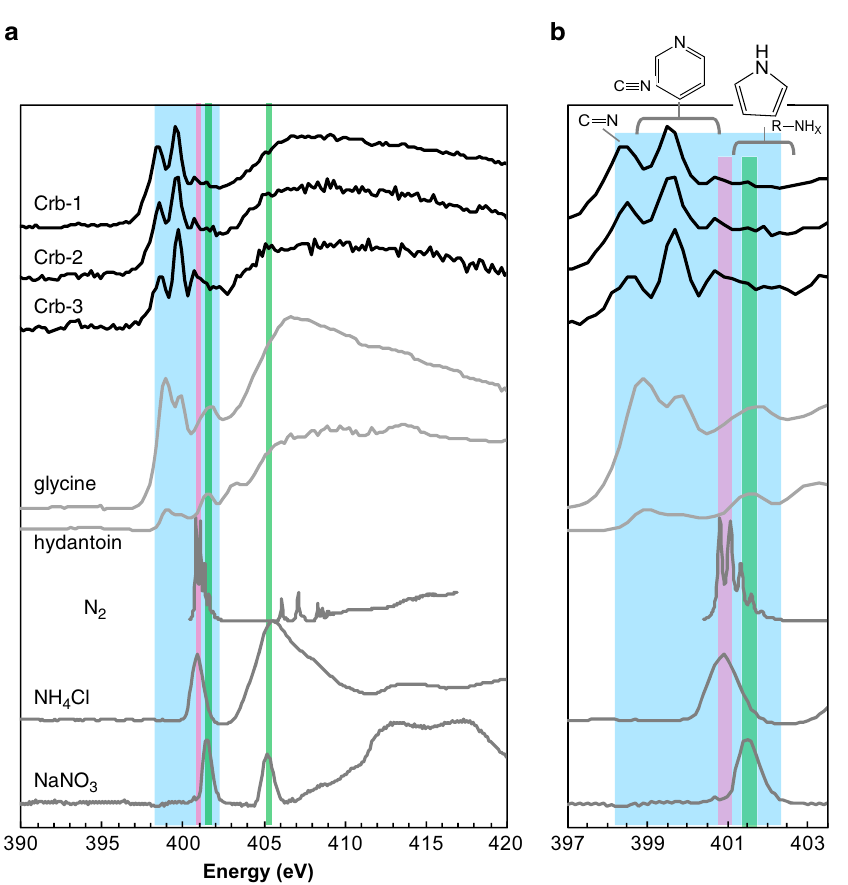
Fig. 2 Nitrogen K-edge XANES spectra. a A whole spectral image. The upper three (Crb-1 to Crb-3) are ALH carbonates, the others are the selected reference compounds. b An enlarged area of the energy between 397 and 403.5 eV. Signi fi cant absorption peaks for N 2 (400.8 eV; magenta), NaNO 3 (401.4 and 405.2 eV; green), and the organic compounds (398 – 402.5 eV; light blue) are highlighted in both images. Major N-bearing groups of imino, nitrile, N-heterocyclic, and amino groups in this energy range are plotted. The other XANES spectra obtained in this study are shown in Supplementary Figs 1 –